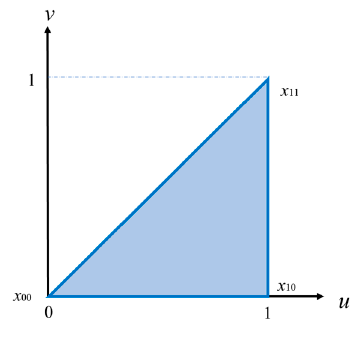
Figure 4. Feature triangle.